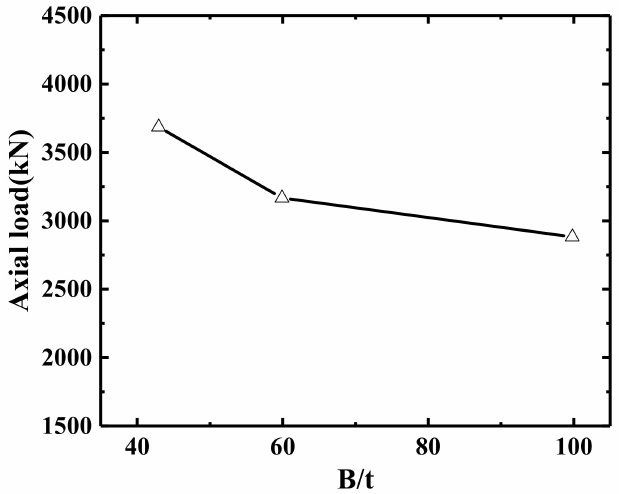
Figure 19. Different diameter-to-thickness ratio specimens of the ultimate load capacity